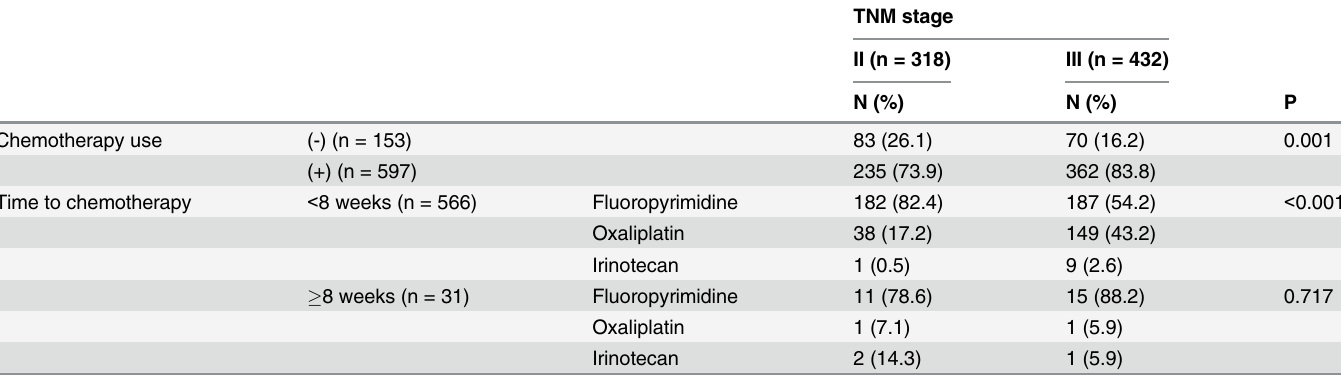
Table 1. Adjuvant